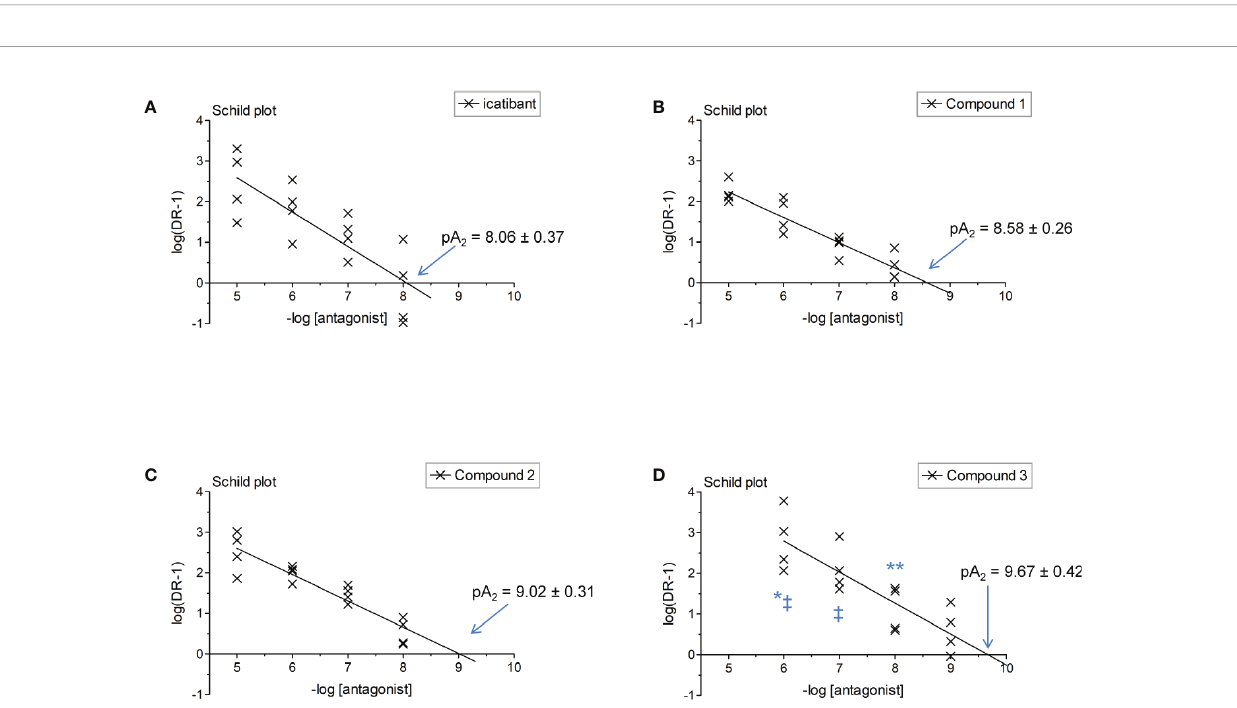
FIGURE 4 | Schild plot analysis of Figure 3 data where a point in the regression represents one day of experimental data for a given antagonist concentration. The identity of the tested antagonist is icatibant (A) , Compound 1 (B) , Compound 2 (C) and Compound 3 (D) . Two-way ANOVA indicated that the antagonist drug identity and concentration determined the variation of log(DR-1) values (P < 10 -4 for each). Values different from those of icatibant: *P < 0.05; **P < 0.01; values different from those of Compound 1: ‡ P < 0.05 (Bonferroni post-hoc